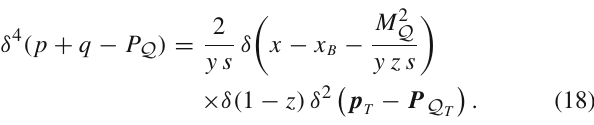
/ψ ( 3 S ) | 0 (cid:3) by v 3 and v 4 , 1 1